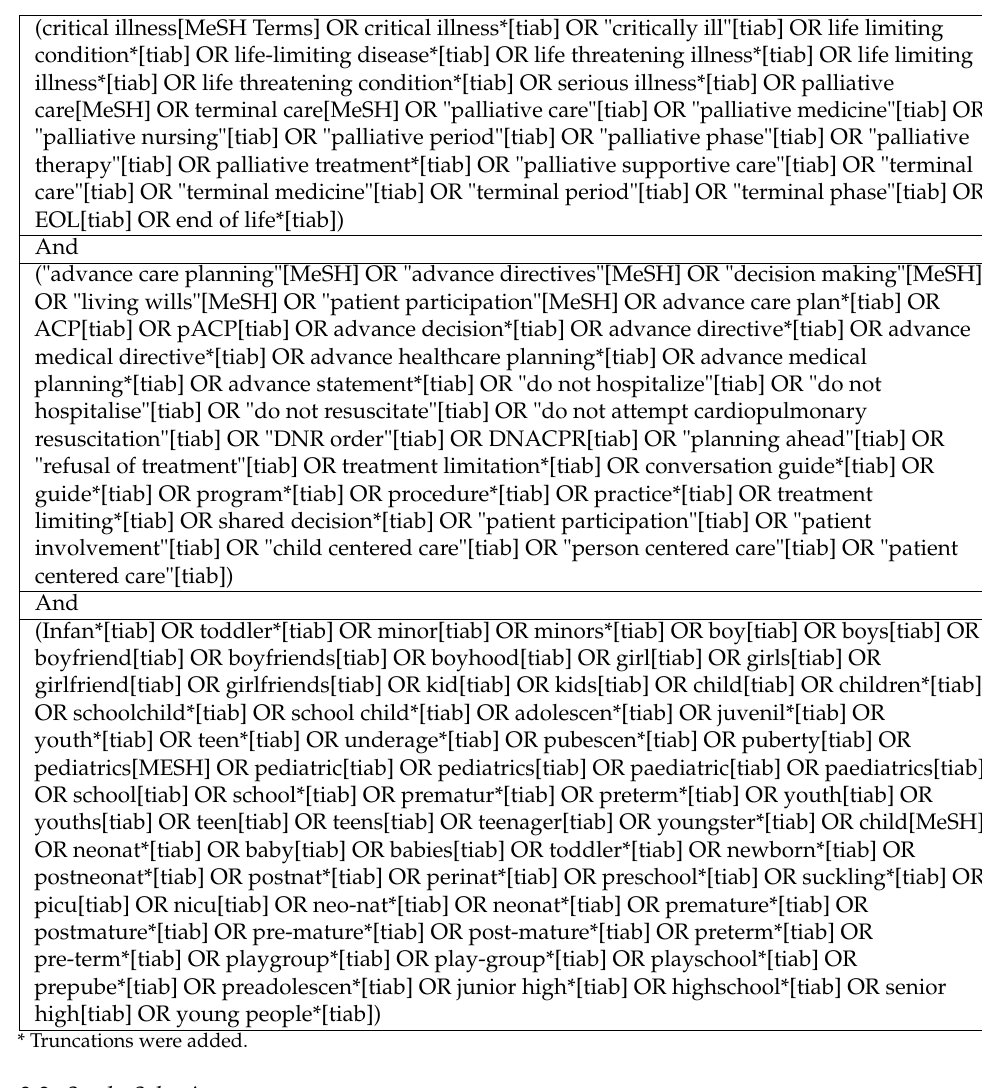
Table 1. Search string for Medline. Search date: 31 August